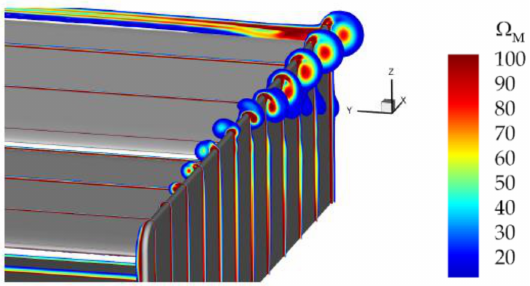
Figure 25. Contour showing the mean vorticity magnitude at several transverse locations ranging from x Wi /c = 0.0189 and x Wi /c = 1.019 along the inboard endplate under the cornering